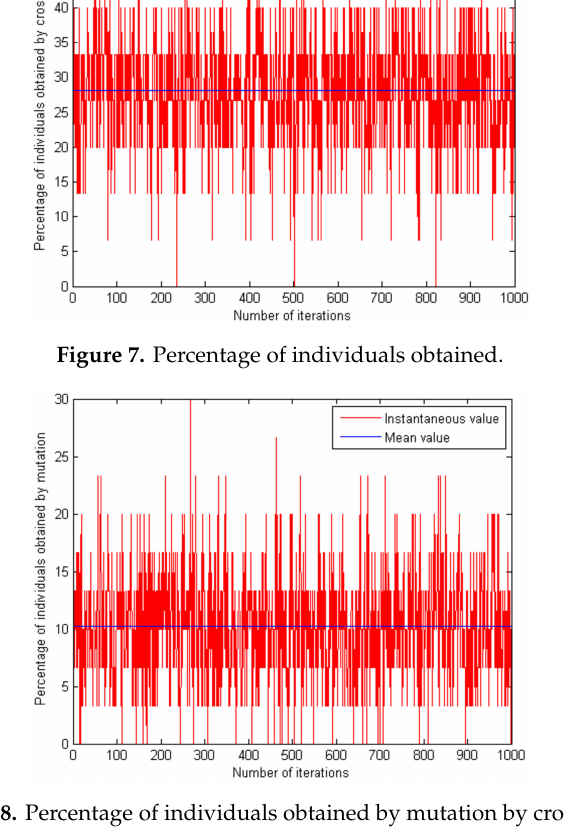
Figure 8. Percentage of individuals obtained by mutation by